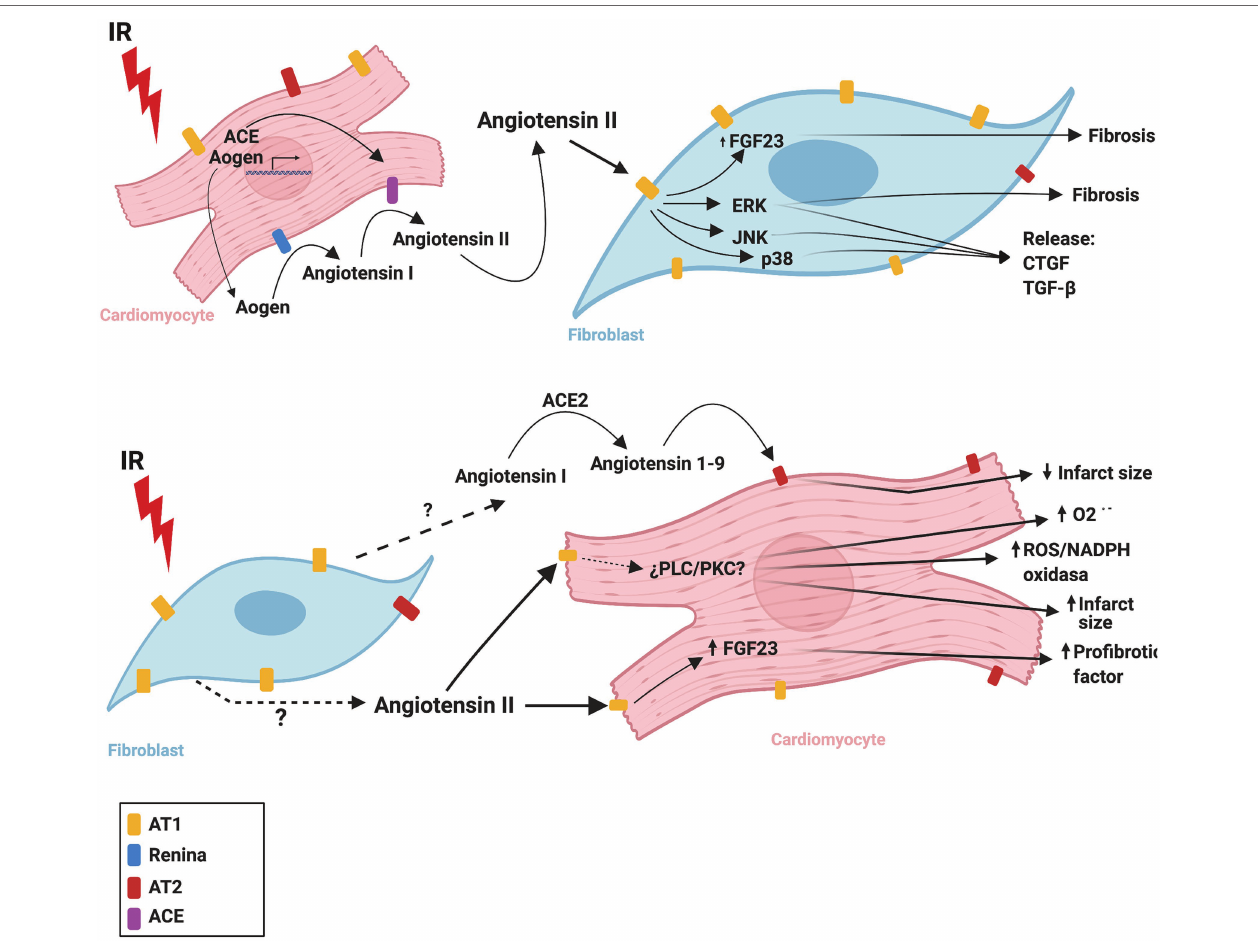
FIGURE 3 | Proposed mechanism of cardiac renin angiotensin system crosstalk between cardiomyocytes and fibroblasts during ischemia/reperfusion. ACE, angiotensin converting enzyme; ACE2, angiotensin converting enzyme 2; AOGEN, angiotensinogen; AT1, angiotensin II receptor type 1; AT2, angiotensin II receptor type 2; CTGF, connective tissue growth factor; ERK, extracellular signal-regulated kinase; FGF23, fibroblast growth factor-23; IR, ischemia reperfusion, JNK, c-Jun N-terminal kinase; NADPH oxidase, nicotinamide adenine dinucleotide phosphate oxidase; O 2-. , superoxide anion; p38, p38 mitogen-activated protein kinase; PLC, phospholipase C; PKC, protein kinase C; TGF- β , transforming growth factor beta. The figure was created using